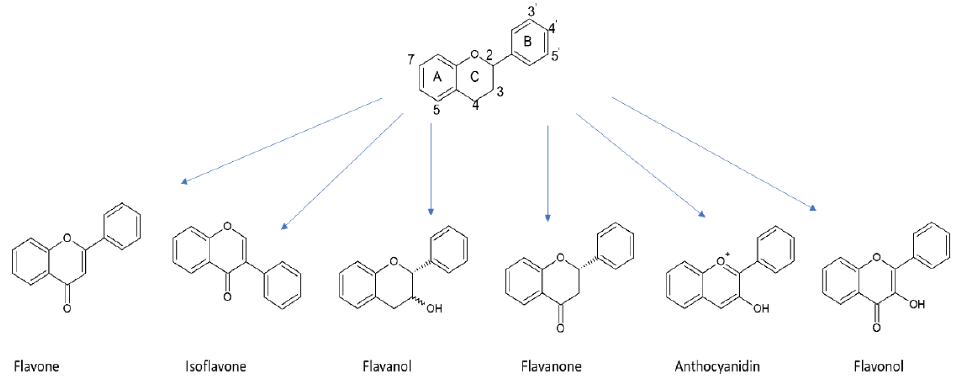
Figure 3. Classification of flavonoids.